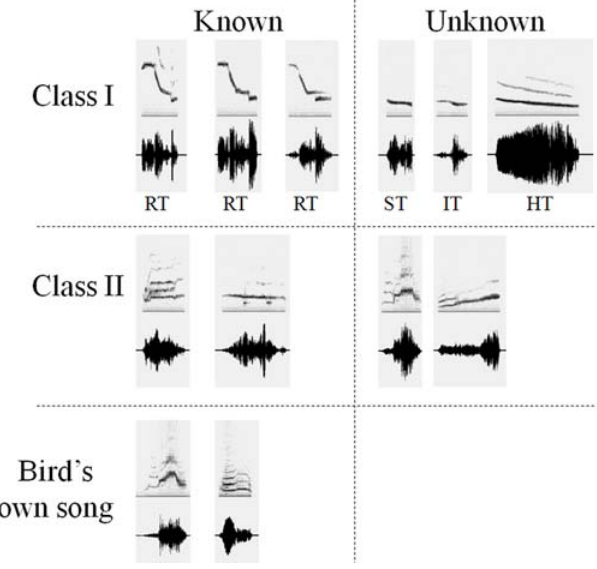
Figure 3. Examples of stimuli used in the experiment [ 20 ] . Every stimulus set included class-I universal whistles (RT: rhythmic